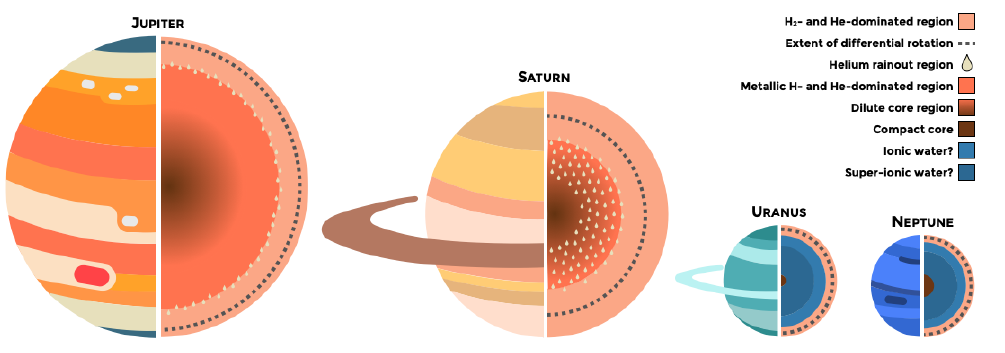
Figure 6. Schematic figure showing the interior structure and relative sizes of the four giants in the solar system. Note that current gravity measurements are not accurate enough to distinguish between different structures for Uranus and Neptune, but mixed rock and ice cores and inhomogeneous structures are also possible (see Section 4.2). Rings and other atmospheric features are not on